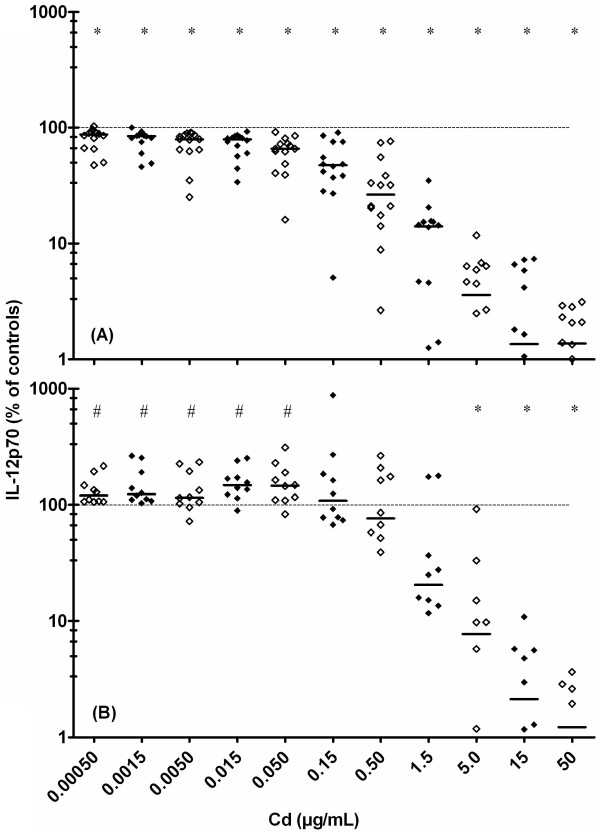
Levels of IL-12p70 released by human PBMC exposed to Cd acetate for 24 hr. Human PBMC were stimulated either by mAb (anti-CD3/-CD28/-CD40) (A) or heat-killed Salmonella enterica (hkSE) (B). Data represent the values of 14 and 10 samples. For each donor, the mean values of 3 replicates were used to estimate the percentage relative to control cells (assigned to 100%). The horizontal lines represent the medians. Symbols above each plot show whether, cytokine release was significantly stimulated (#) or suppressed (*) compared to controls (Wilcoxon's Rank Sum test for paired samples; p < 0.05).